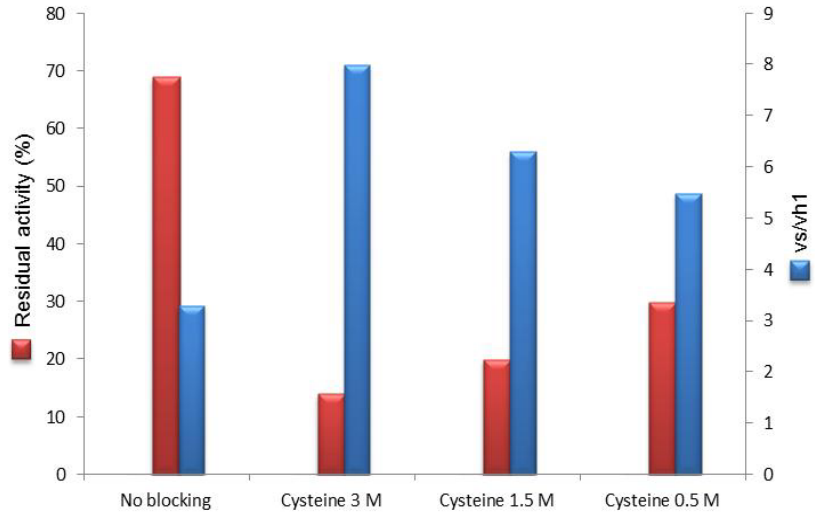
Percentage of enzymatic activity recovery after blockage and vs/vh Reaction conditions (saturating conditions): 4 °C, pH 6.5, acyl donor 10 mM, 7-ACA 50 mM. Immobilization : loading = 200 IU/g (14.3 mg of